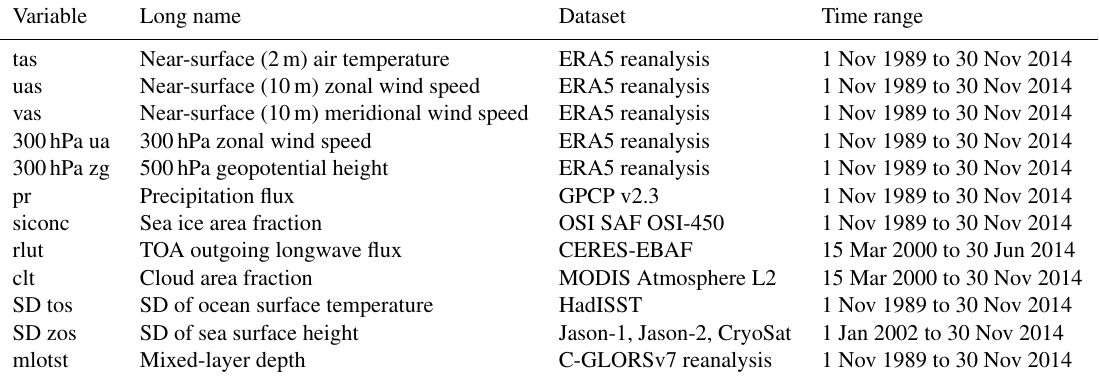
Table C1. Table of observational datasets for climate model performance index calculation.